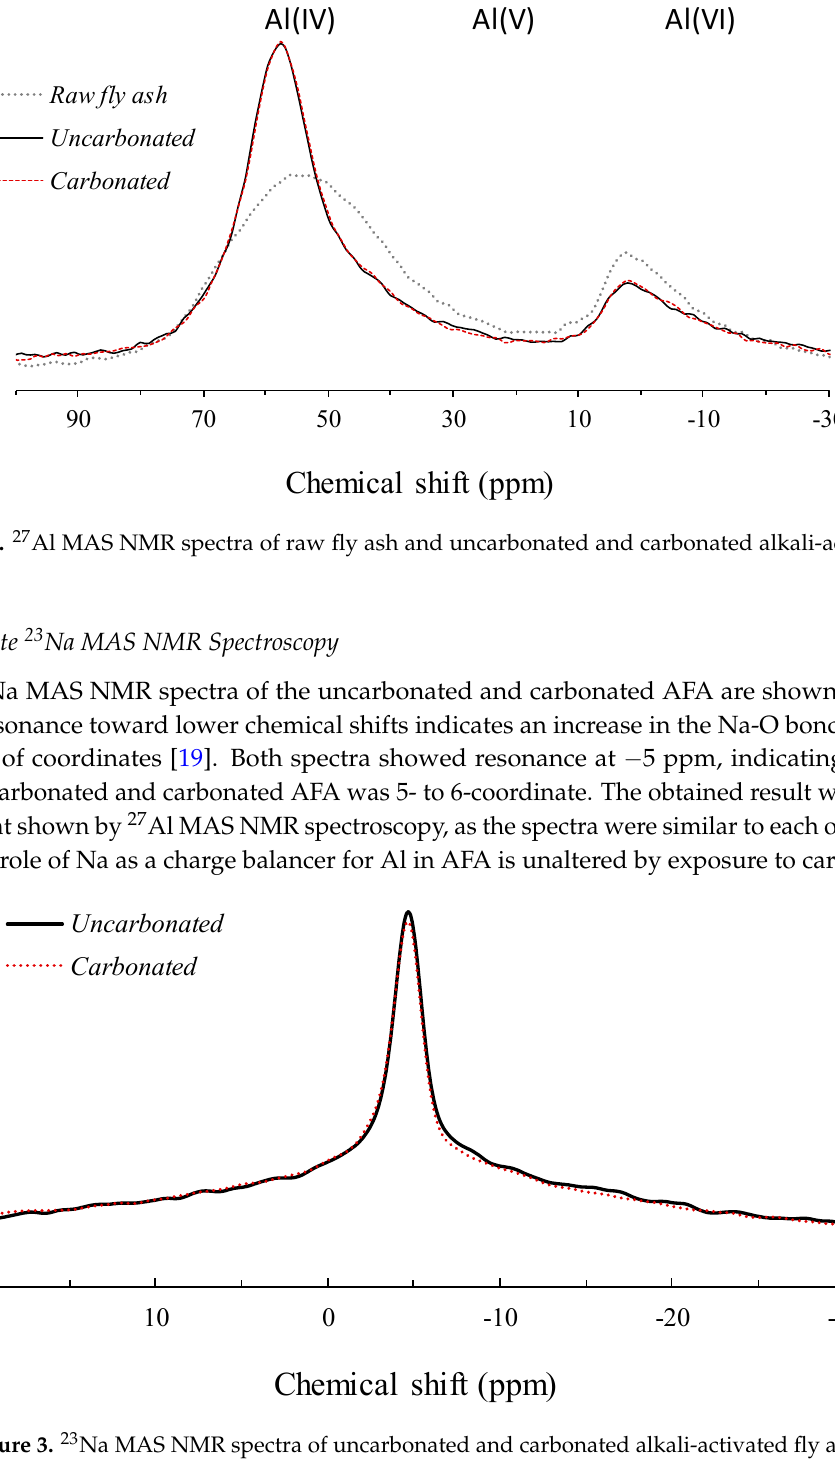
Figure 3. 23 Na MAS NMR spectra of uncarbonated and carbonated alkali-activated fly ash.